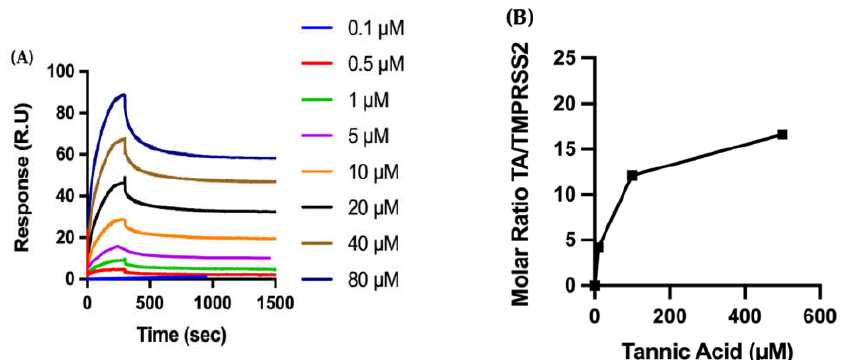
Figure 4. Biophysical characterization of the molecular interactions between TA and TMPRSS2. ( A ) The recombinant protein TMPRSS2 is immobilized on a CM5 sensor chip, and increasing concentrations of TA are injected to evaluate binding kinetics by SPR. ( B ) TMPRSS2 is adsorbed to a gold QCMD sensor, and various concentrations of TA are flowed over the surface for 30 min. TA adsorp- tion is expressed by the dimensionless molar ratio of adsorbed TA to adsorbed TMPRSS2.